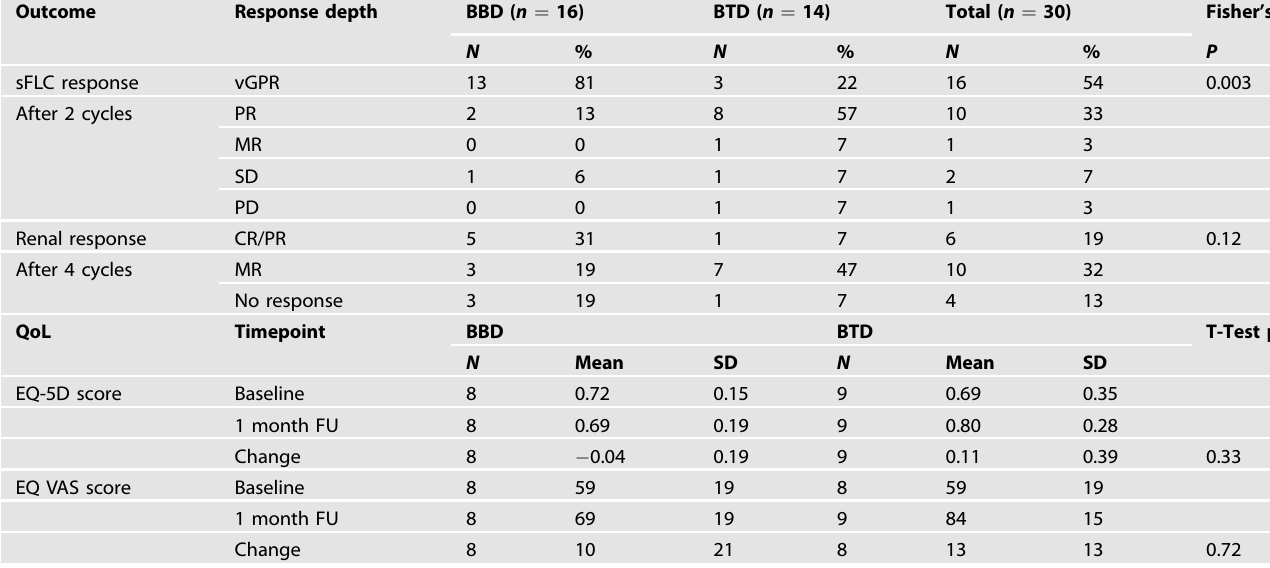
Table 2. Primary outcomes sFLC response to two cycles of therapy, renal response to 4 cycles of therapy, and Quality of Life (EQ-5D-3L index and EQ VAS scores) by treatment